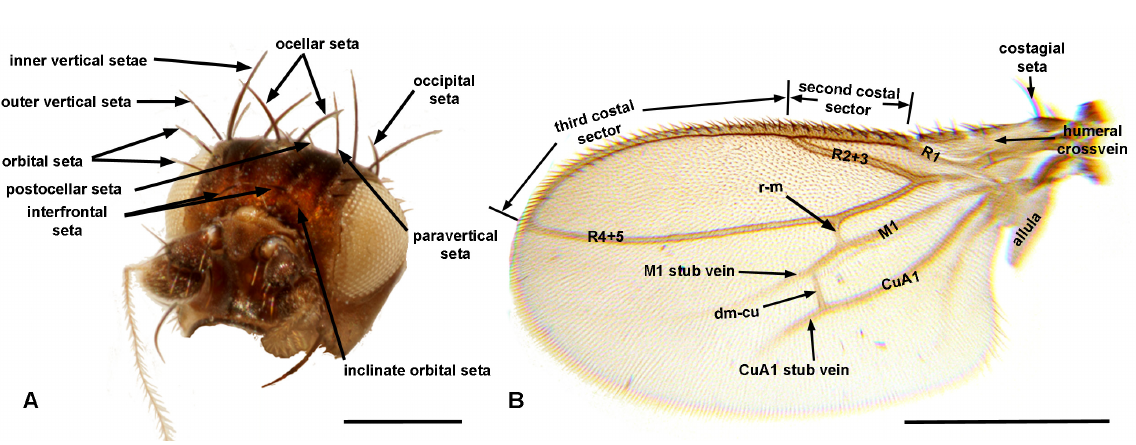
Fig. 1. A . Rudolfina howdeni sp. nov., head (debu01086104). B . R. exuberata sp. nov., wing (debu00276674). Scale bars: A = 0.20 mm; B = 0.35 mm.